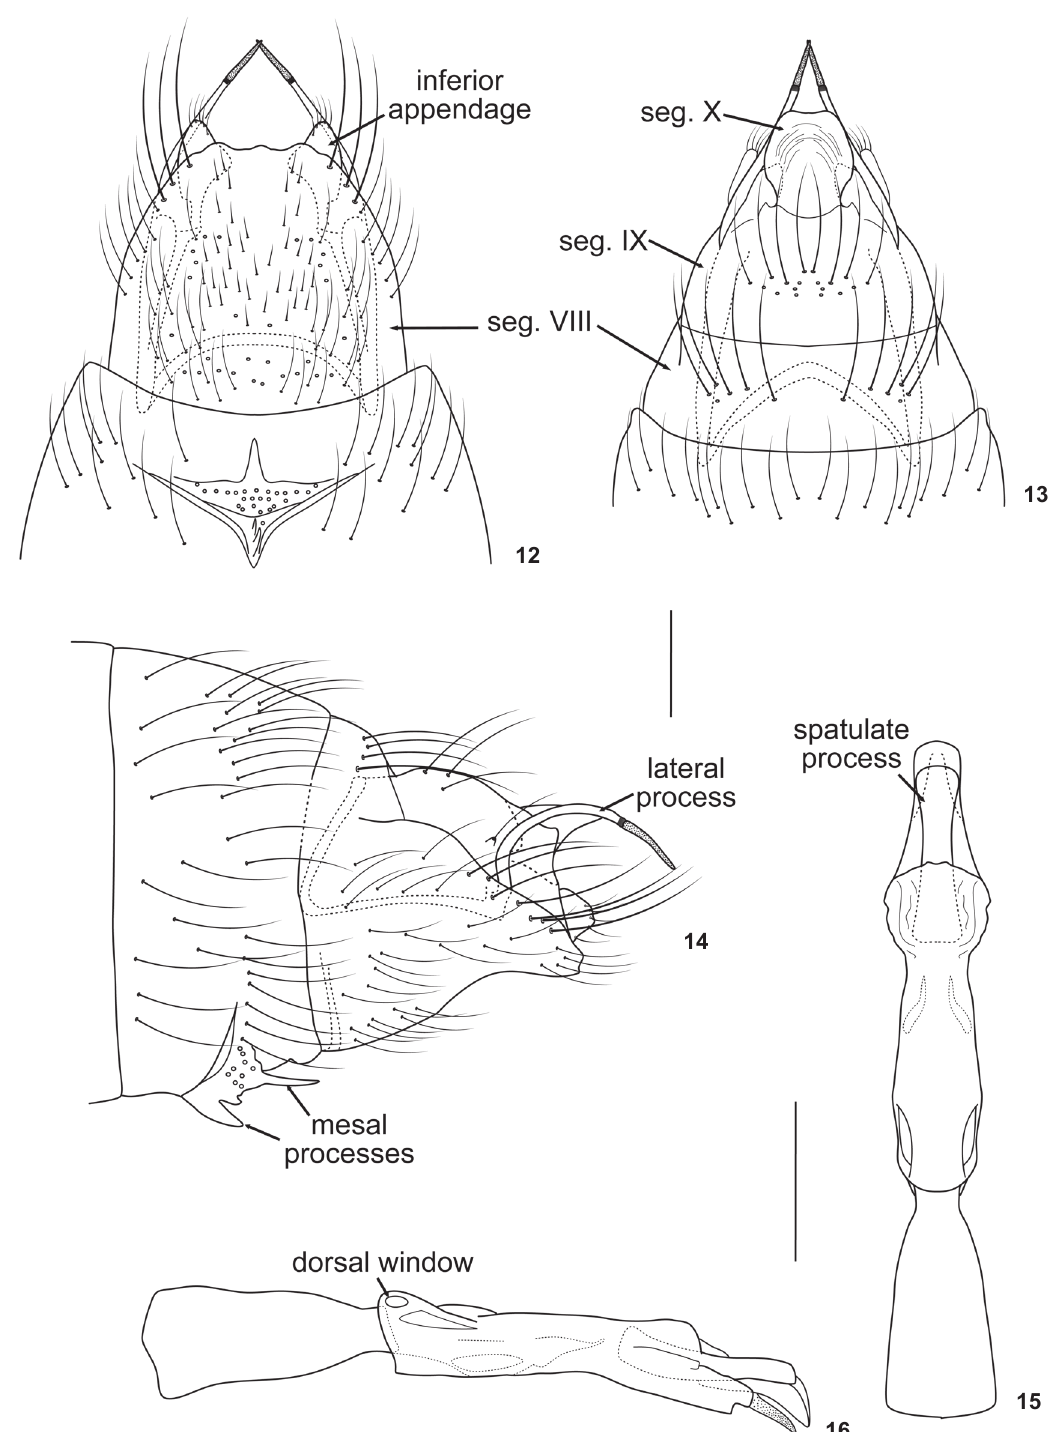
Figures 12-16. Costatrichia fluminensis sp. nov. , male genitalia: (12) ventral view; (13) dorsal view; (14) lateral view; (15) phallus, dorsal view; (16) phallus, lateral view. Scale bar = 0.1